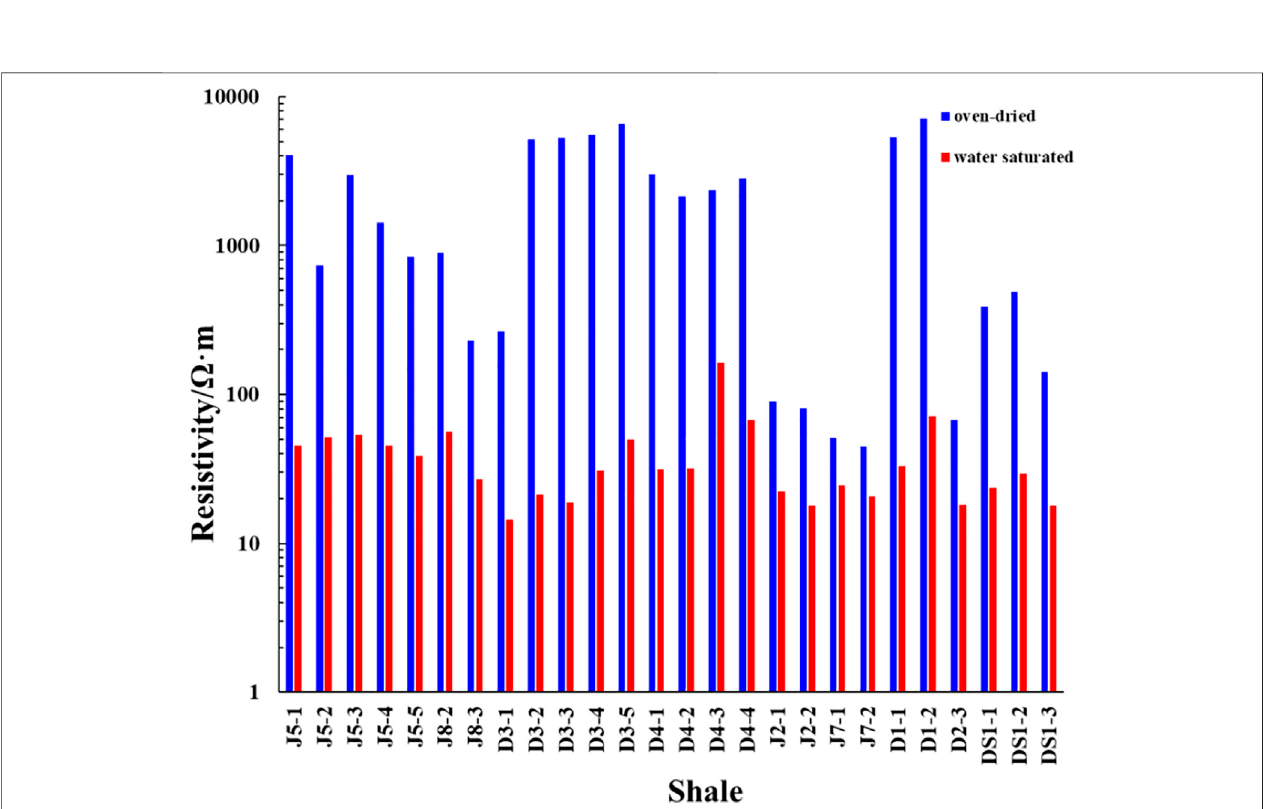
Frontiers in Earth Science |